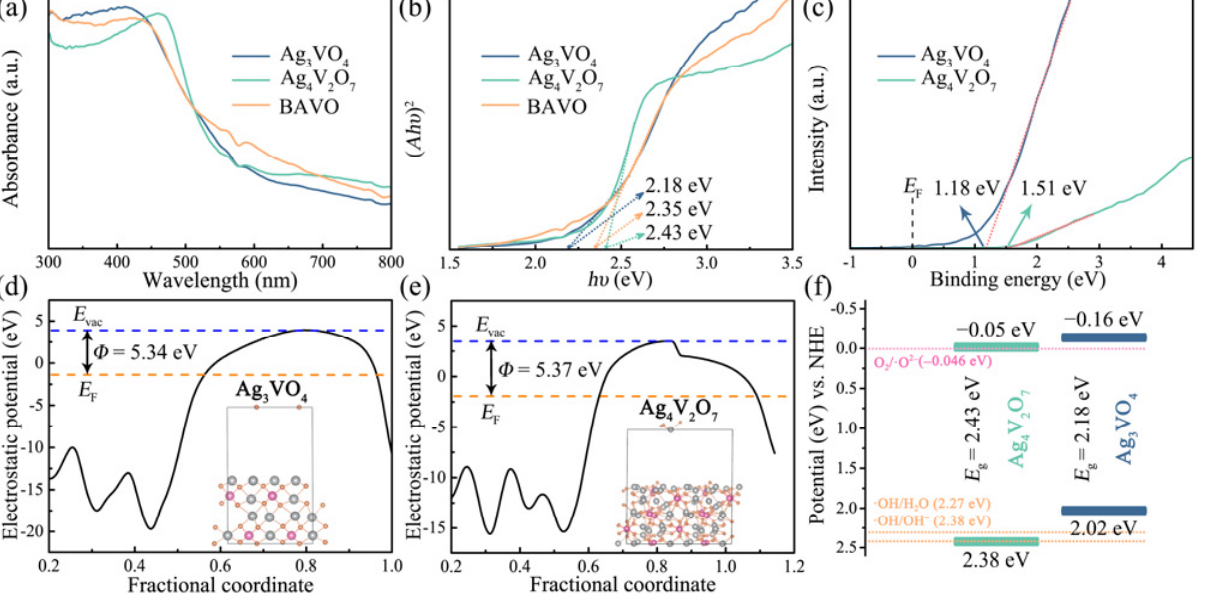
Fig. 5 Electronic structure analysis: (a) UV–Vis absorption spectra and (b) plot of ( Ah υ ) 2 vs. h υ for Ag 3 VO 4 , Ag 4 V 2 O 7 , and BAVO; (c) VB-XPS spectra of Ag 3 VO 4 and Ag 4 V 2 O 7 ; (d, e) calculated Fermi levels and work functions of Ag 3 VO 4 and Ag 4 V 2 O 7 , respectively; and (f) electronic band structures of Ag 3 VO 4 and Ag 4 V 2 O 7